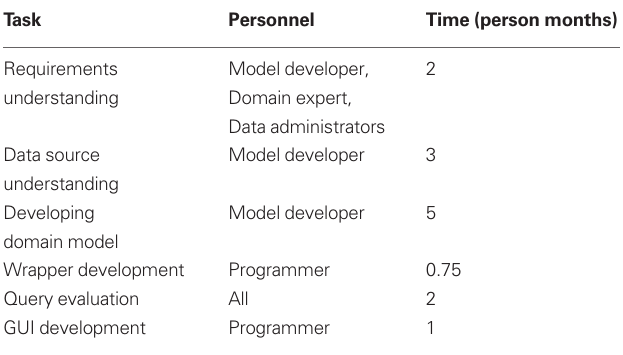
Table 3 | FBirN application development